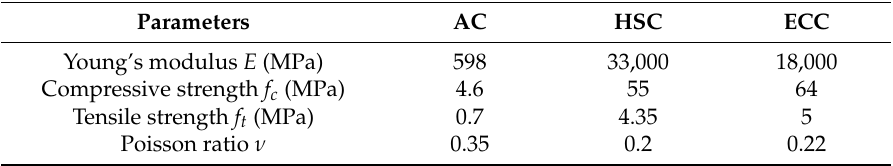
Table 3. Basic properties of materials in the multi-layer pavement for the blast load.